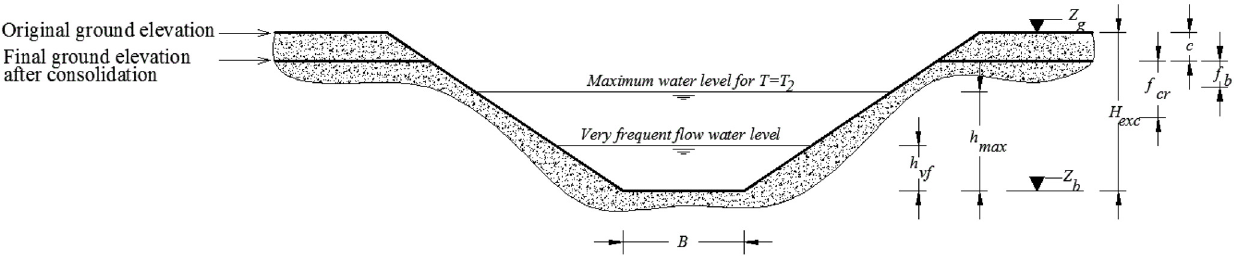
Figure 1. Rural drainage networks: definition sketch of the symbols